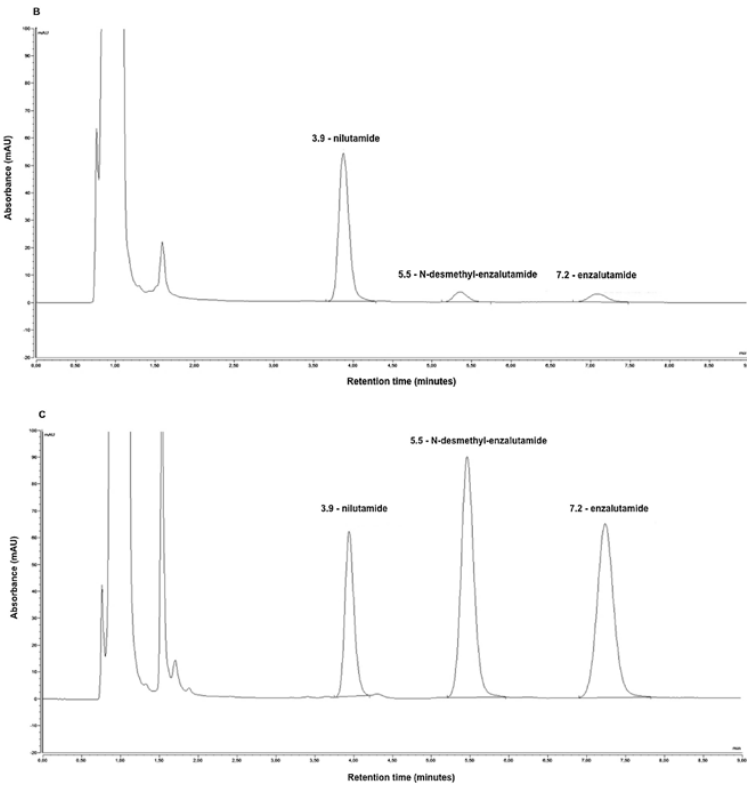
Figure 2. Representative HPLC-UV chromatograms of ( A ) blank human plasma, ( B ) lower limit of quantification of enzalutamide and N - desmethyl enzalutamide (0.50 μg/mL for both) and nilutamide (internal standard), ( C ) plasma from a metastatic castration-resistant prostate cancer patient treated with 160 mg of enzalutamide once daily (plasma concentration of enzalutamide and N - desmethylenzalutamide: 10.9 μg/mL and 12.4 μg/mL, respectively) [2 7].